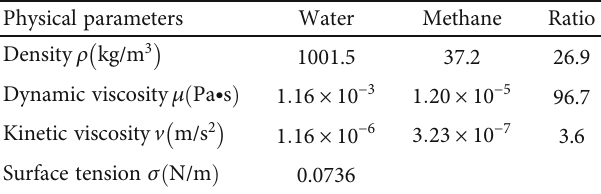
Table 2: Methane and water parameters at 14 ° C and 5MPa. Physical parameters